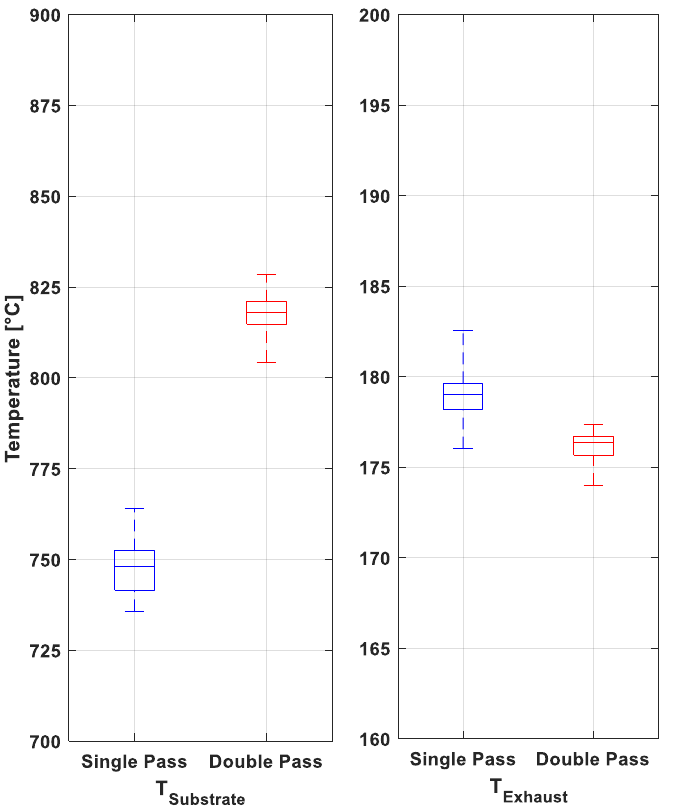
Figure 5. A comparison of mean temperatures T substrate and T exhaust for the single pass and double pass inlets at 6000 mL/min air flow rate with 2SSC